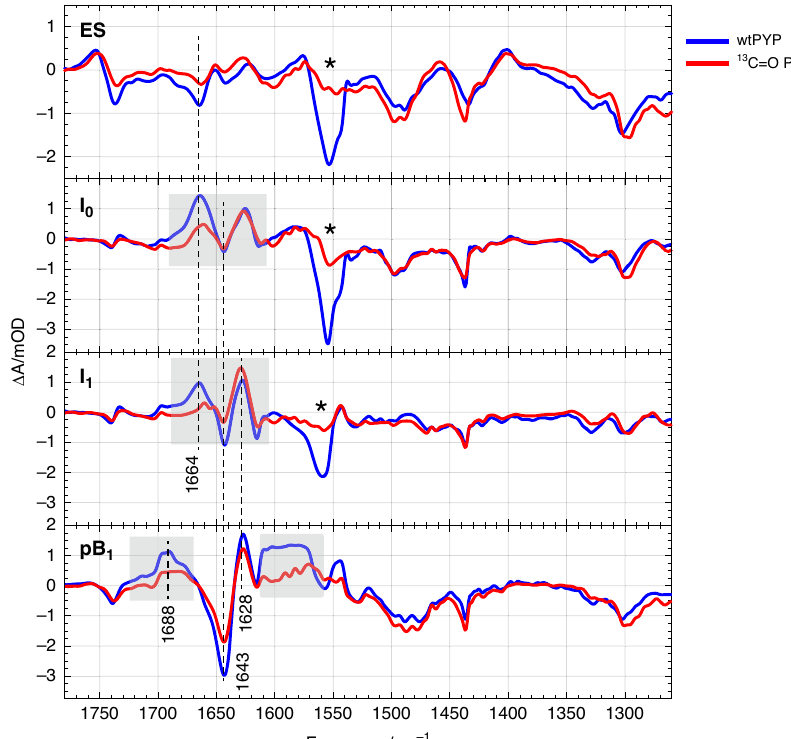
Fig. 8 Mid-IR SADS of wild type and isotope-labeled PYP at position C9. WT-PYP (blue) and 13 C = O - PYP (red) SADS of the ES, I 0 , I 1 , pB 1 states are shown in the region between 1780 – 1250 cm − 1 . In the region 1540 to 1250 cm − 1 the labeled PYP spectrum was scaled by a factor 0.5 for better comparison with the unlabeled spectra, whereas from 1780 to 1540 cm − 1 no scaling was performed. The differences induced upon labeling of the carbonyl of pCa of PYP with 13 C are highlighted with colored boxes in the graph and systematic losses around 1555 cm − 1 bleach is shown by a star (*)